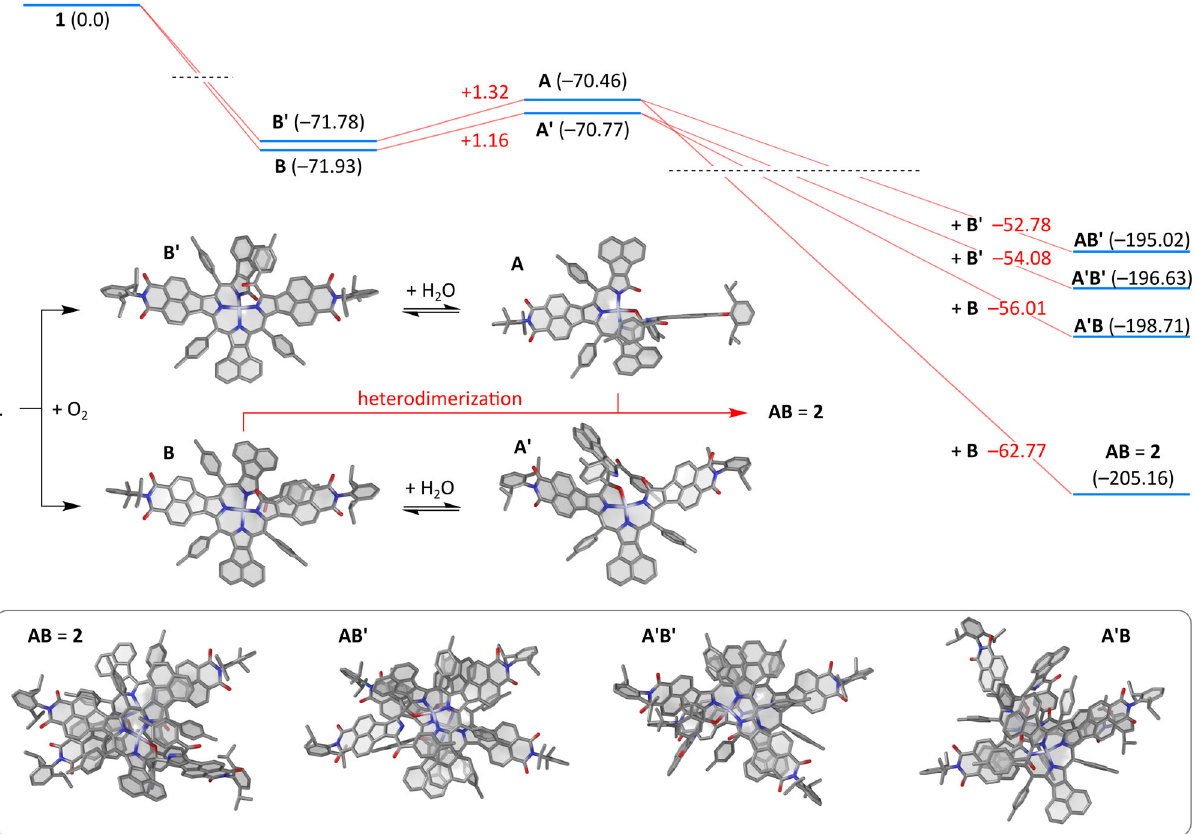
Fig. 7 Thermodynamics of heterodimer formation explored using density functional theory. (SMD(toluene)/GD3BJ-B3LYP/6 – 31 G(d,p)). Δ G 298 (in kcal/mol) are given relative to 1 (black) and the preceding intermediate (red). Vertical positions of energy bars are not to